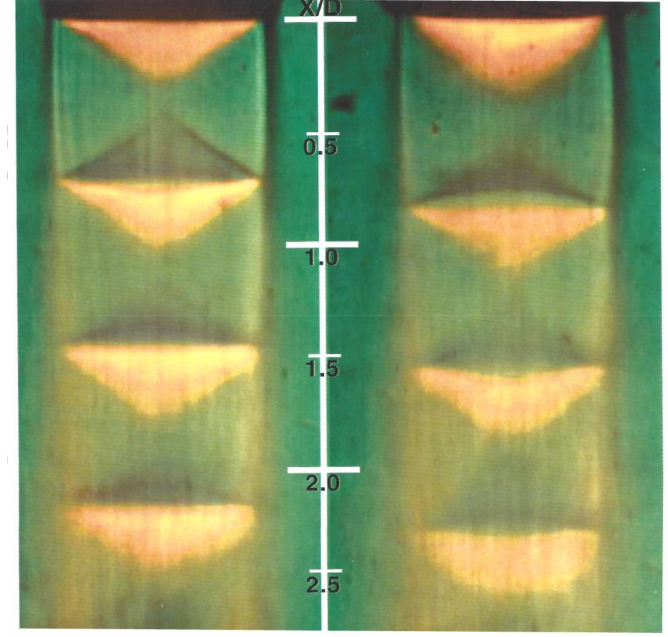
Figure 20. Schlieren image for NPR = 2.40: ( left ) LU48P; ( right )